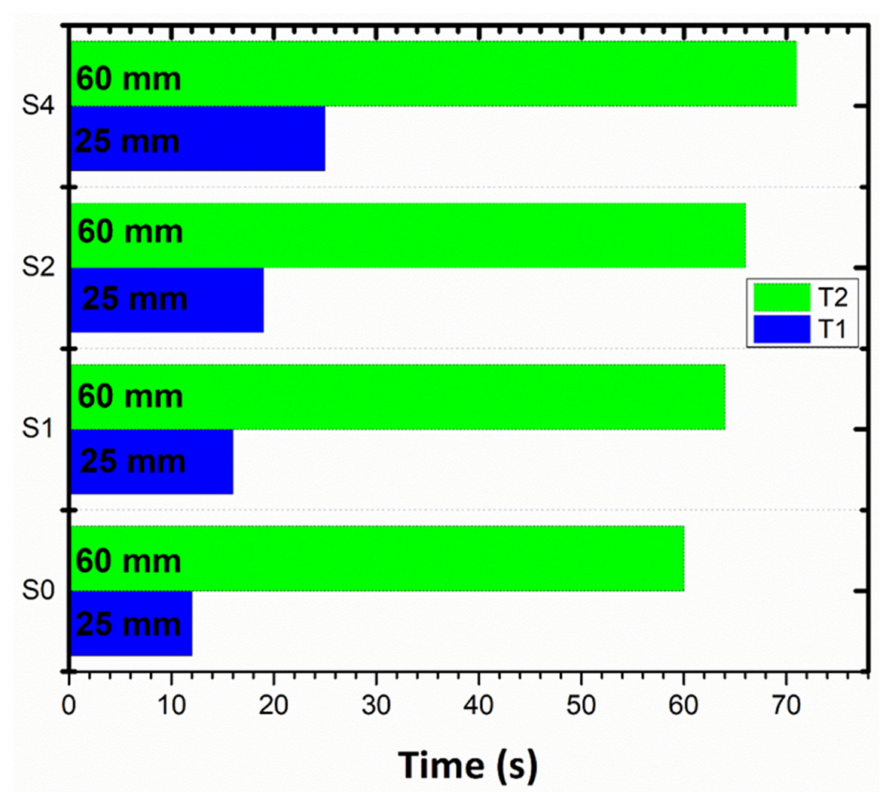
Figure 10. Increase in flame retardancy upon addition of m-sepiolite from S0–S4 samples in terms of T1 and